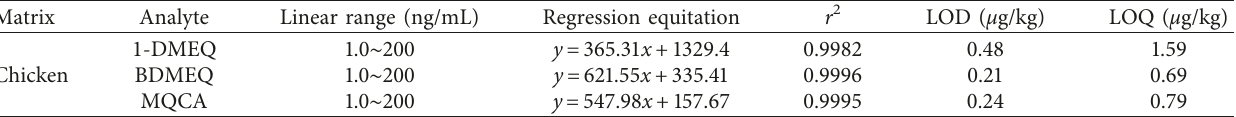
Table 3: Parameters (including the standard curve, LOD, and LOQ) of MQCA, 1-DMEQ, and BDMEQ in holothurian samples. Matrix